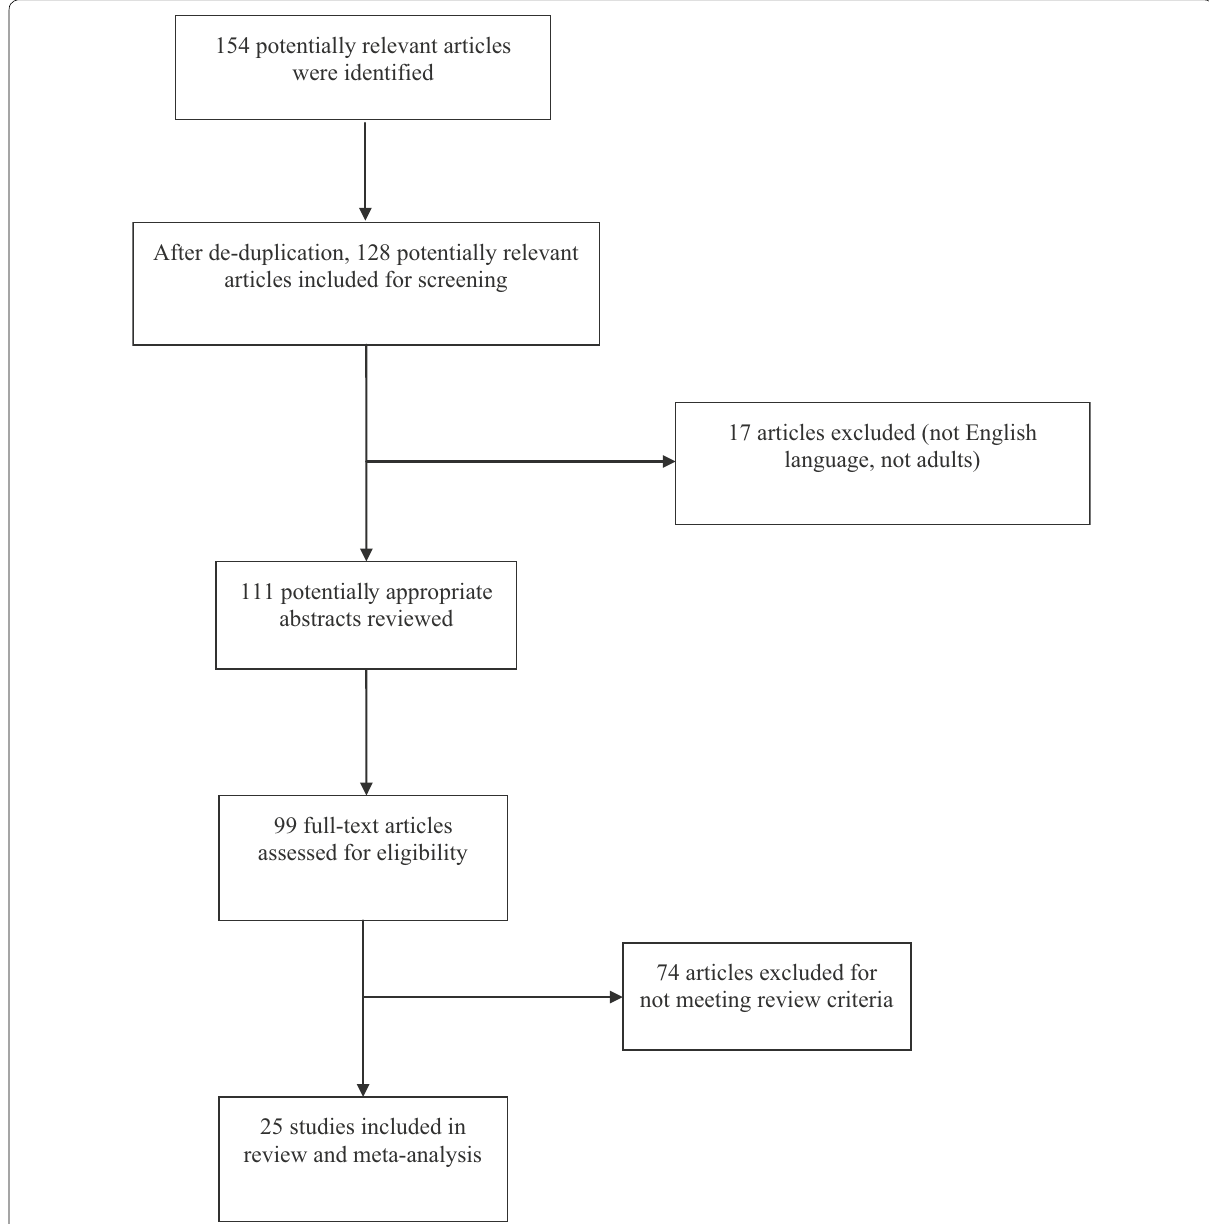
Fig. 1 Preferred reporting items for systematic reviews and meta-analysis (PRISMA) flow